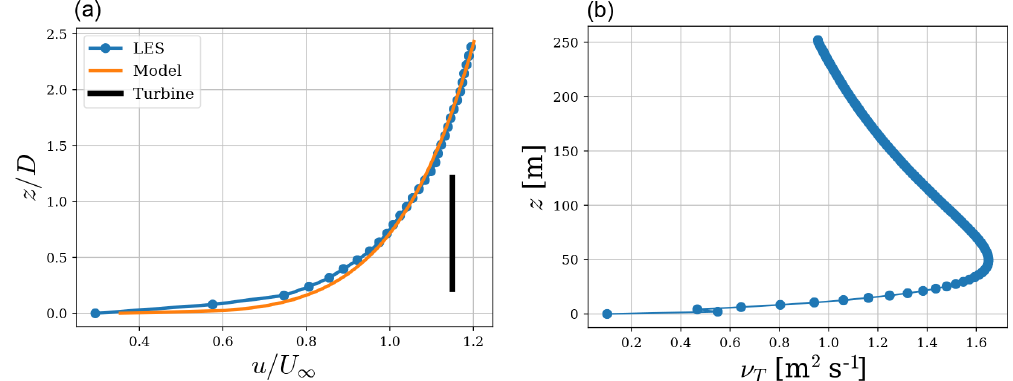
Figure 6. Atmospheric boundary layer inflow (a) from the LES and from a power law used in the model with shear exponent α = 0 . 15. The corresponding turbulence viscosity profile (b) as a function of height is shown.